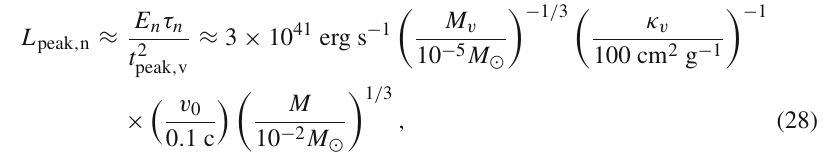
τ / t ∼ 0 . 01 − 0 . 1 of this energy is available to be radiated over a n peak , v